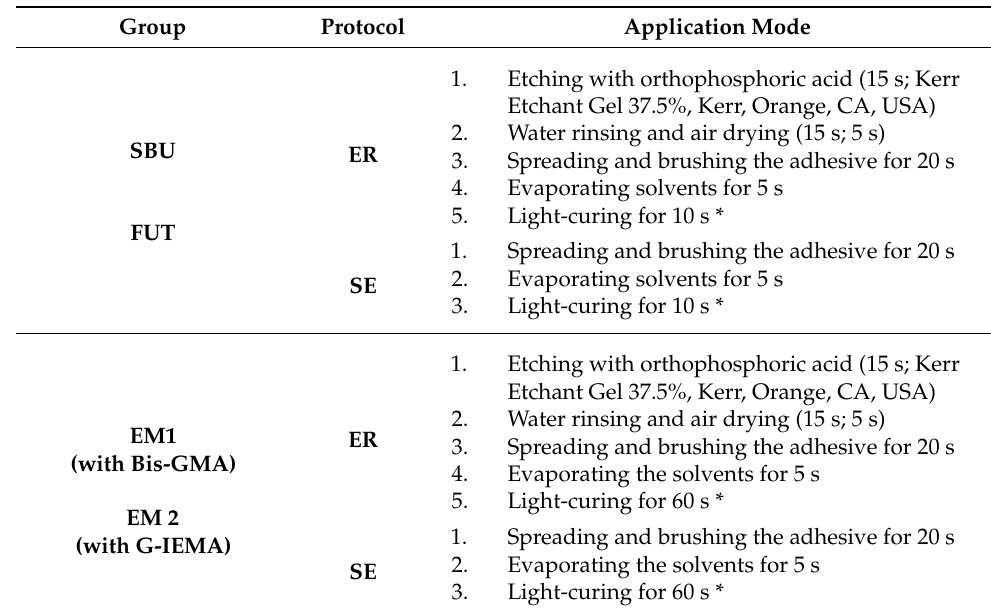
Table 2. Description of the application mode for each adhesive and respective adhesive strategy